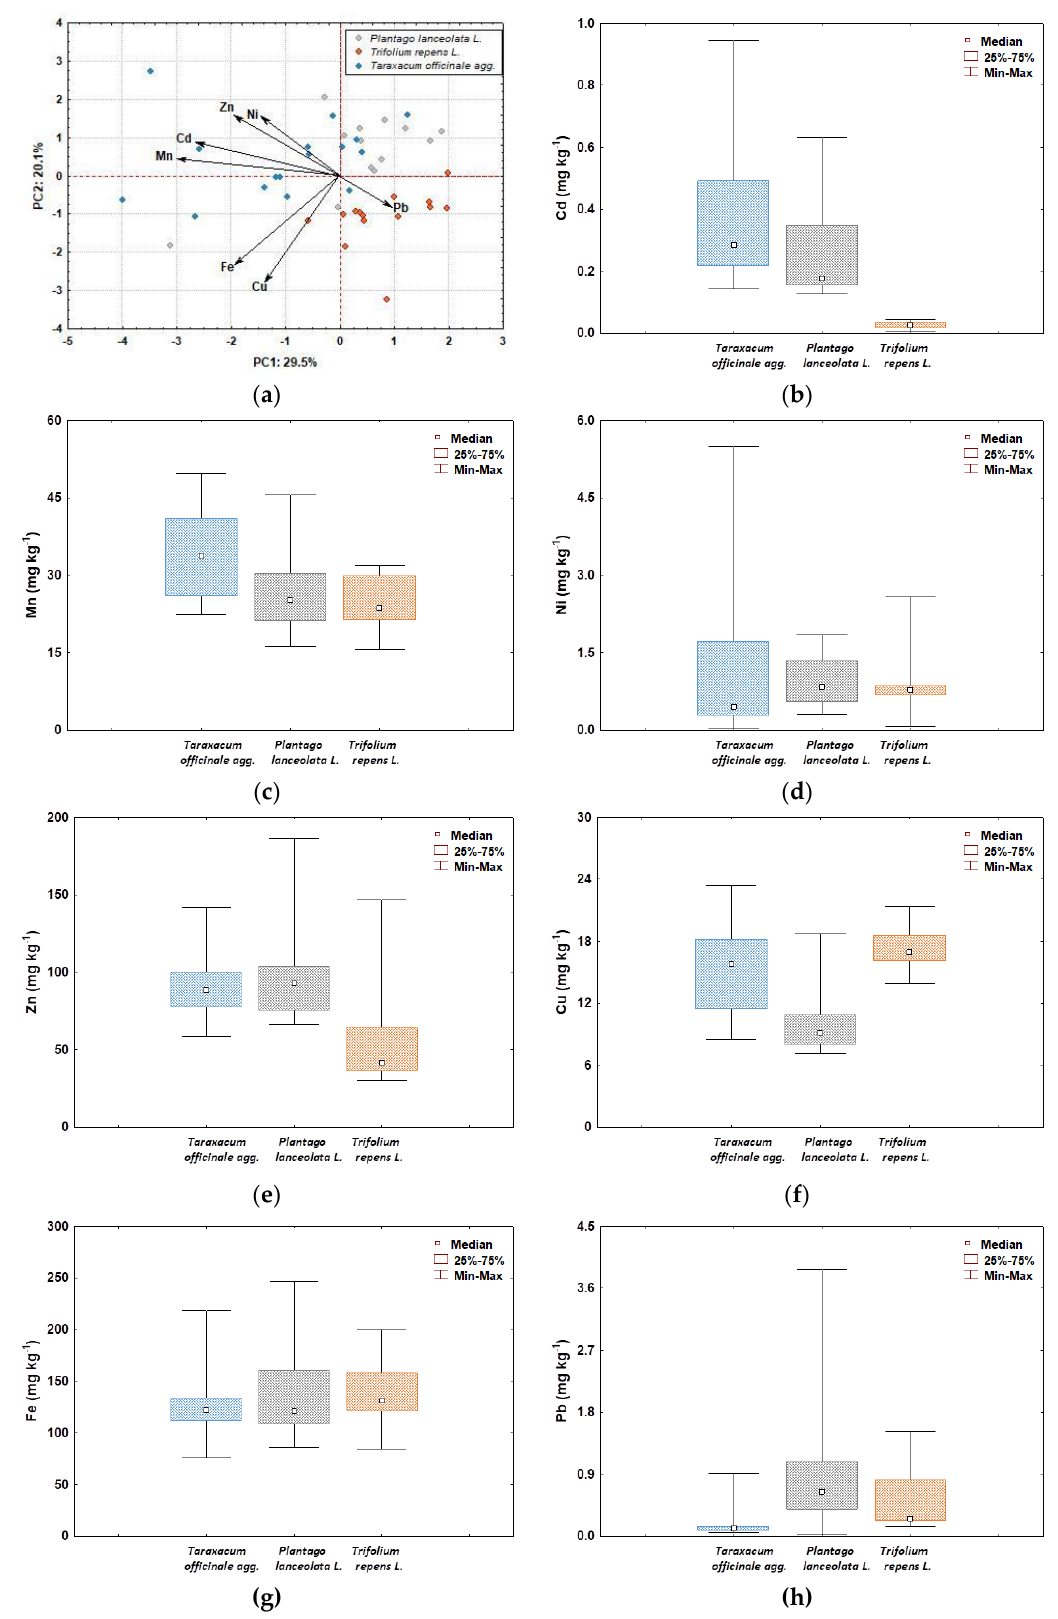
Figure 2. PCA biplot ( a ) and boxplots of total HM concentrations (Cd, Cu, Fe, Mn, Ni, Pb, and Zn) in washed samples of Taraxacum officinale , Plantago lanceolata , and Trifolium repens (b – h)